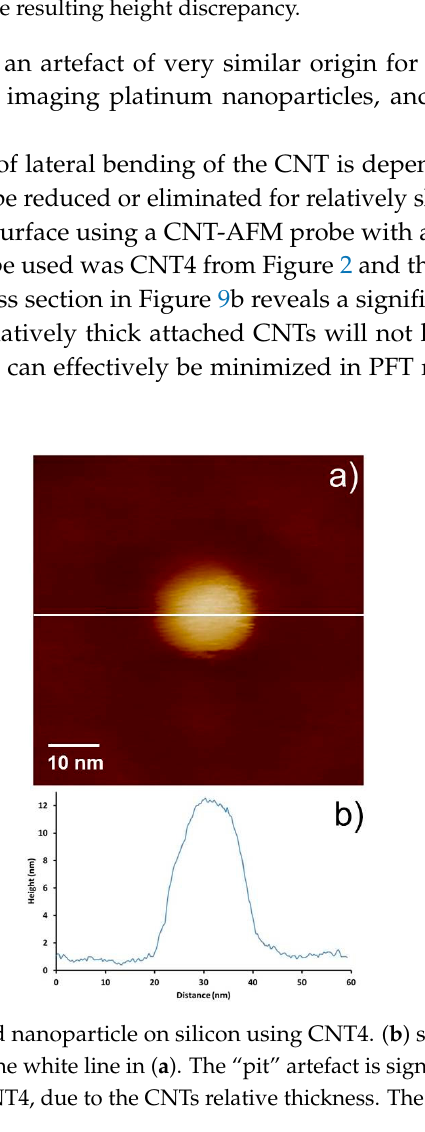
Figure 8. Schematic of a CNT tip during an oscillation cycle in the proximity of a nanoparticle, showing adhesion and buckling with the resulting height discrepancy.